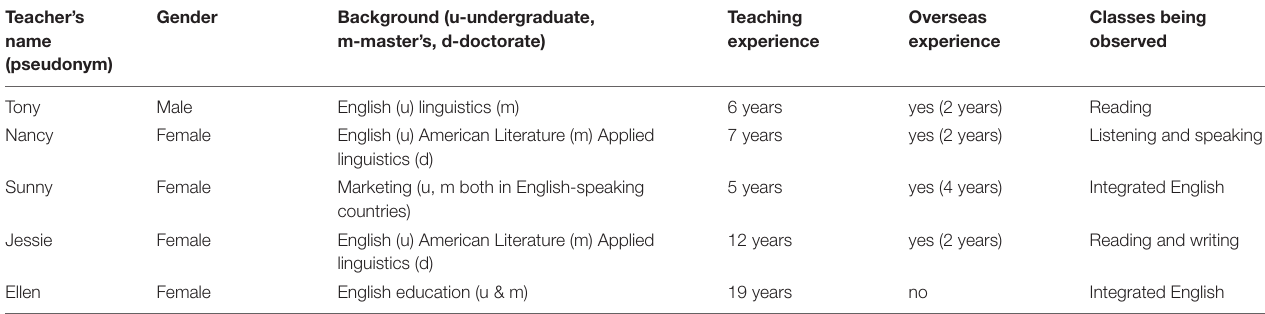
TABLE 1 | Case study teachers’